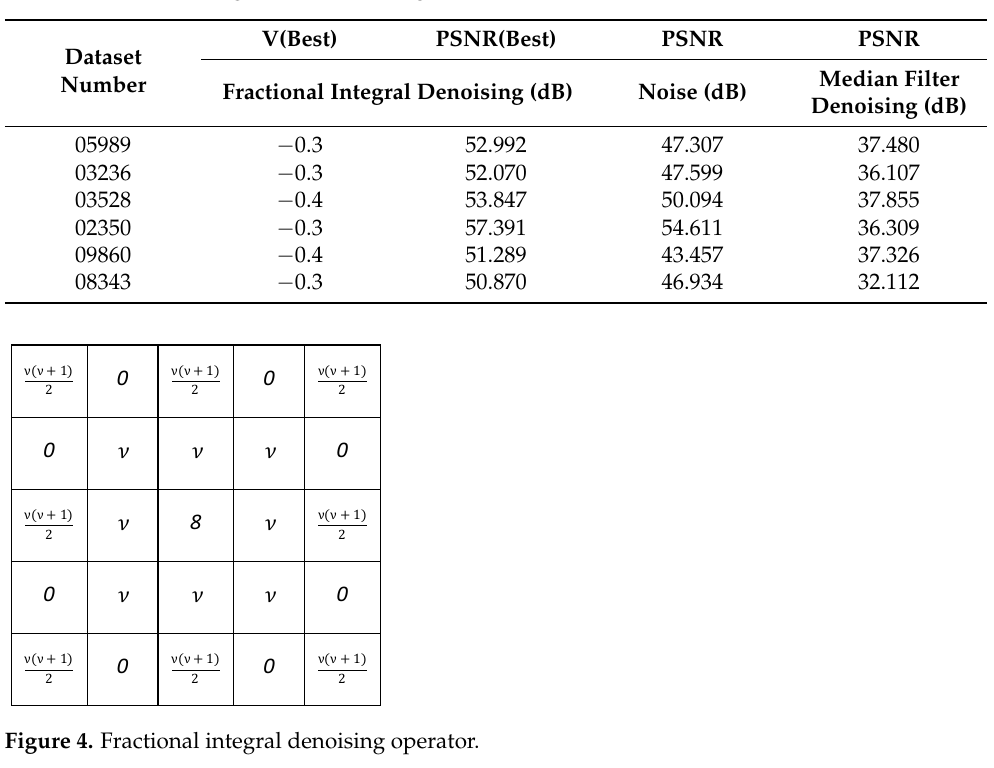
Table 1. Fractional integral filter denoising results.